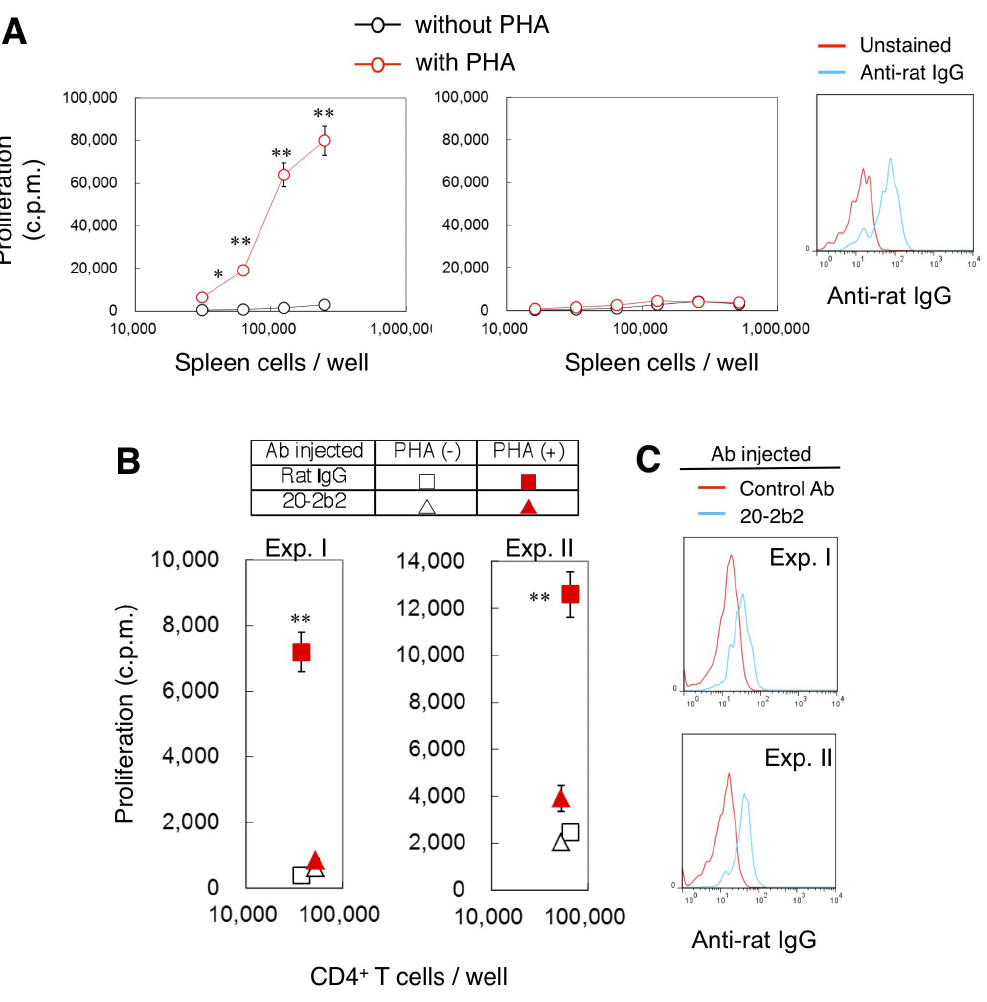
Figure 5. 20-2b2 induced CD4 + T cell anergy invivo . (A) Hu-NOG mice were intravenously injected with one of the following Abs (100 m g/ mouse); control Ab (rat IgG) (left panel) or 20-2b2 (middle panel). Whole spleen cells were prepared and cultured in the presence (red) or absence (black) of PHA (1 m g/ml) twenty-four hours later. Cell proliferation was measured two days later. Values are shown as means 6 SD of triplicate cultures. Aliquots of spleen cells from 20-2b2-injected Hu-NOG mice were stained with the anti-CD4 Ab with or without the anti-rat IgG Ab. Staining with the anti-rat IgG Ab on CD4 + T cells is shown as blue line. CD4 + T cells without anti-rat IgG Ab staining are shown as red lines. Data are representative of more than five experiments. (B) Two NOG mice (2 Gy irradiated) as recipients were inoculated with spleen cells from one Hu-NOG mouse. One NOG mouse as a recipient was injected with the control Ab (square, 20 m g/mouse) and another NOG mouse with 20-2b2 (triangle, 20 m g/ mouse). CD4 + T cells were prepared from these NOG mice seven days later and cultured in the presence (closed red) or absence (open black) of PHA (1 m g/ml). Cell proliferation was measured three days later. Values are shown as the mean 6 SD of triplicate cultures. (C) Aliquots of CD4 + T cells from control Ab-injected (red lines) or 20-2b2-injected NOG mice (blue lines) in (B) were stained with anti-rat IgG. Data from two individual experiments (Exp. I and Exp. II) are shown. * p , 0.01, ** p , 0.001 by the Student’s t -test, cell proliferation induced by the PHA stimulation with the control Ab versus the 20-2b2